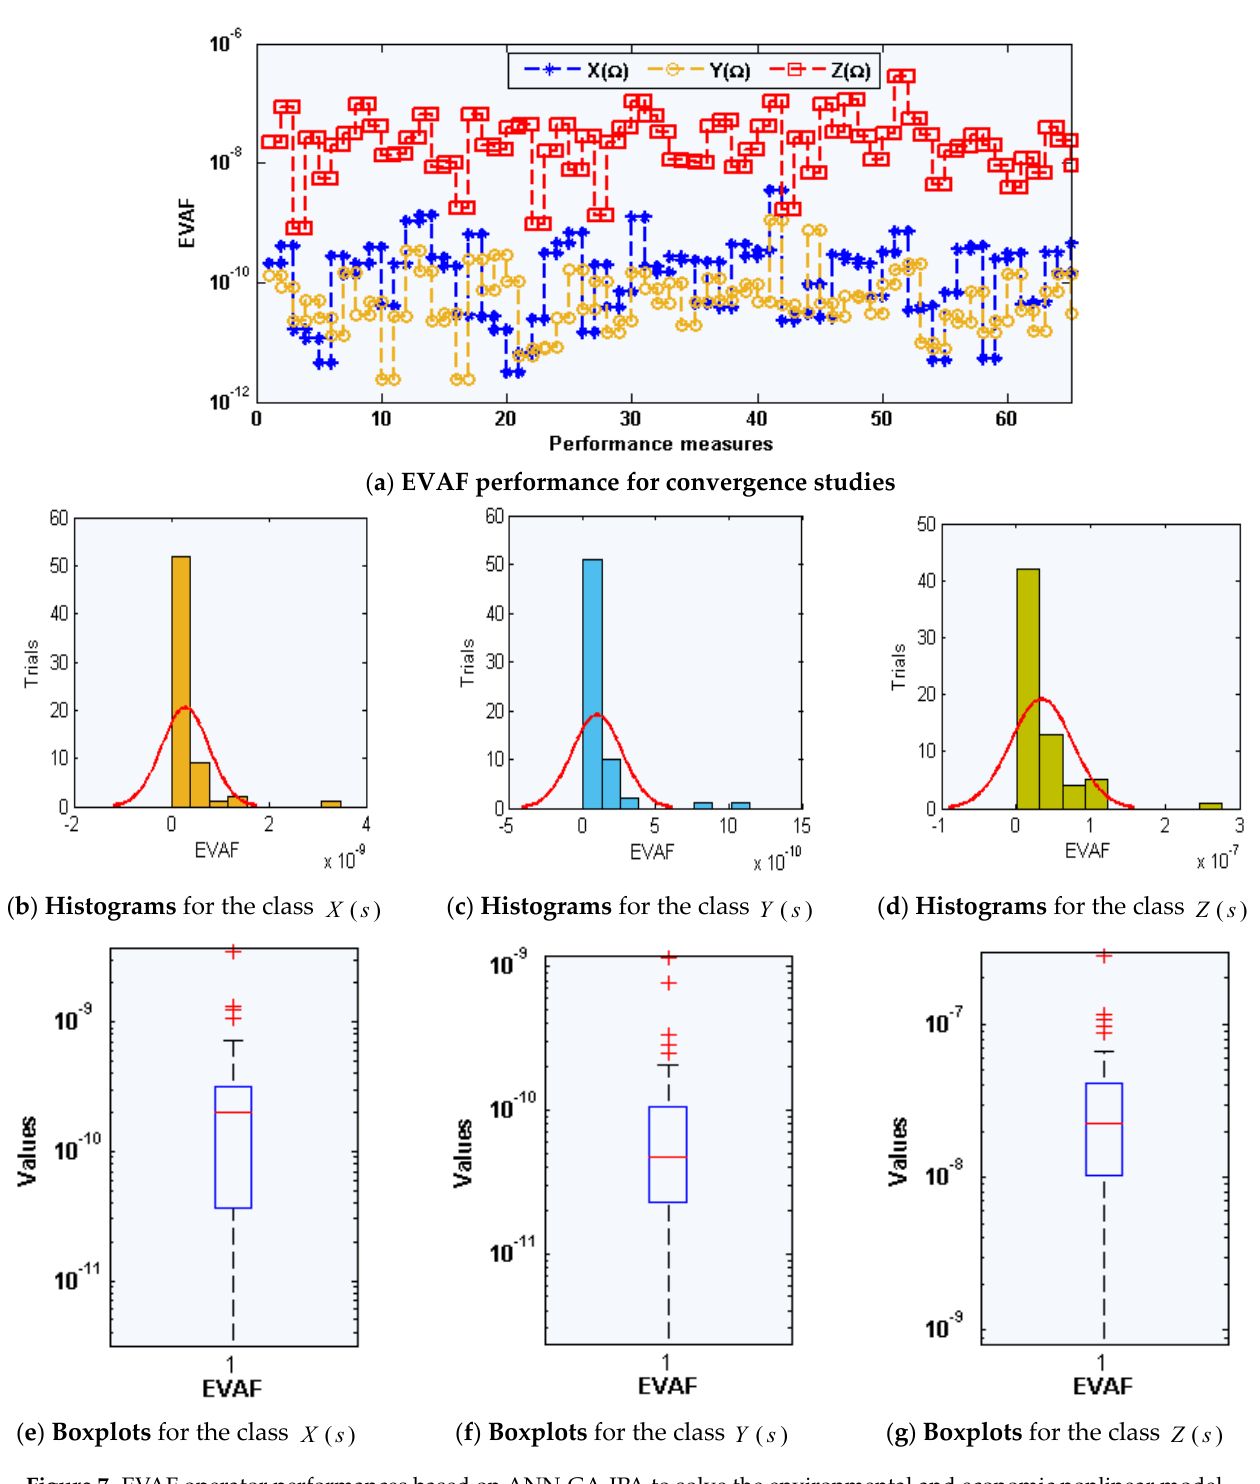
Figure 7. EVAF operator performances based on ANN-GA-IPA to solve the environmental and economic nonlinear model. Table 3. Statistical presentations of the environmental and economic nonlinear model for ( ) Y s .